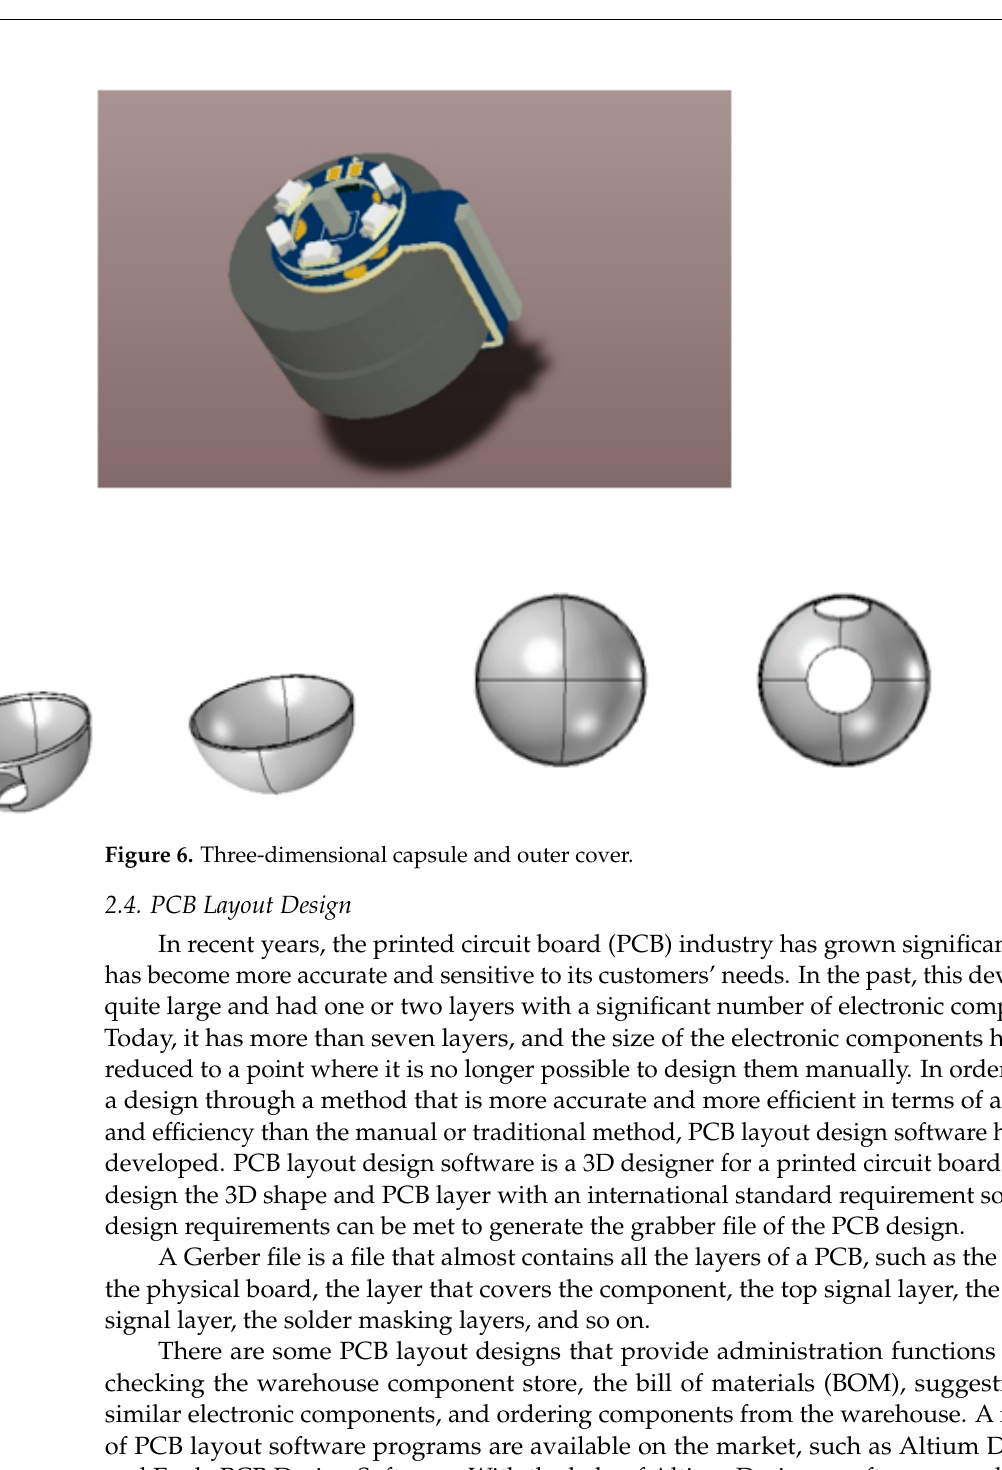
Figure 5. 399 Renata battery .